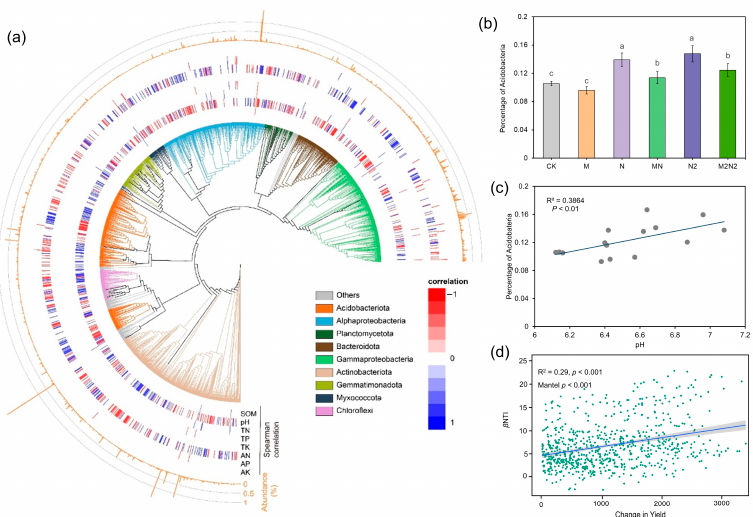
Figure 4. Phylogenetic tree of the microbial phylotypes and relationship between microbial community and soil properties. ( a ) Predominant phyla across all treatments; ( b ) Percentage of Acidobateria phylum in different treatments; ( c ) Correlation between the percentage of Acidobateria phylum and soil pH; ( d ) Correlation between β nti and crop yield. Bars with different letters (shown in above) are significantly different ( p < 4. Discussion 4.1. Organic Fertilization Mitigated the Decline of the Soil Bacterial α -Diversity Caused by Chemical N Fertilization in Black Soils